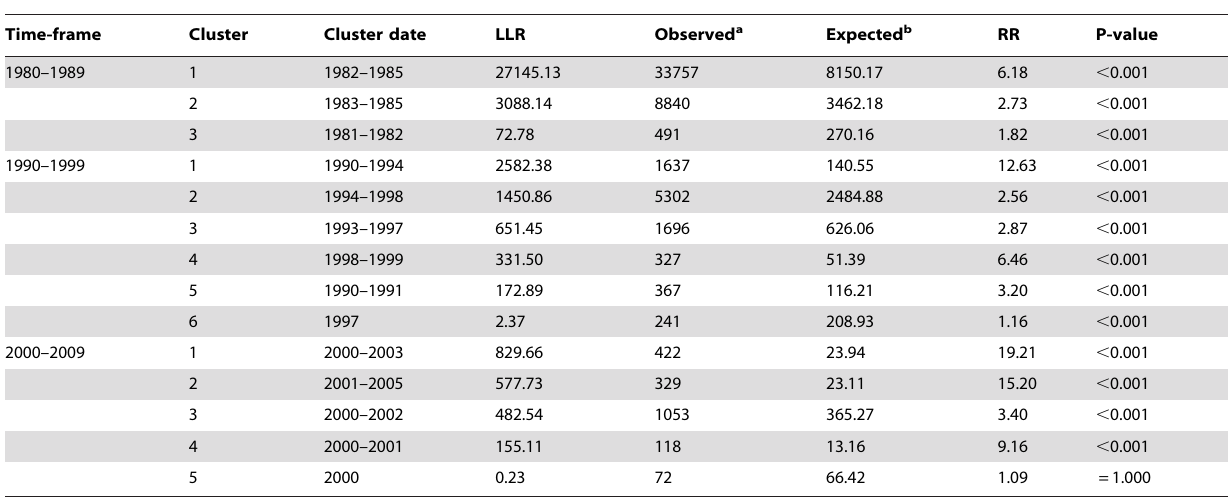
Table 1. Detection of HFRS Clusters in Hubei Province, China.